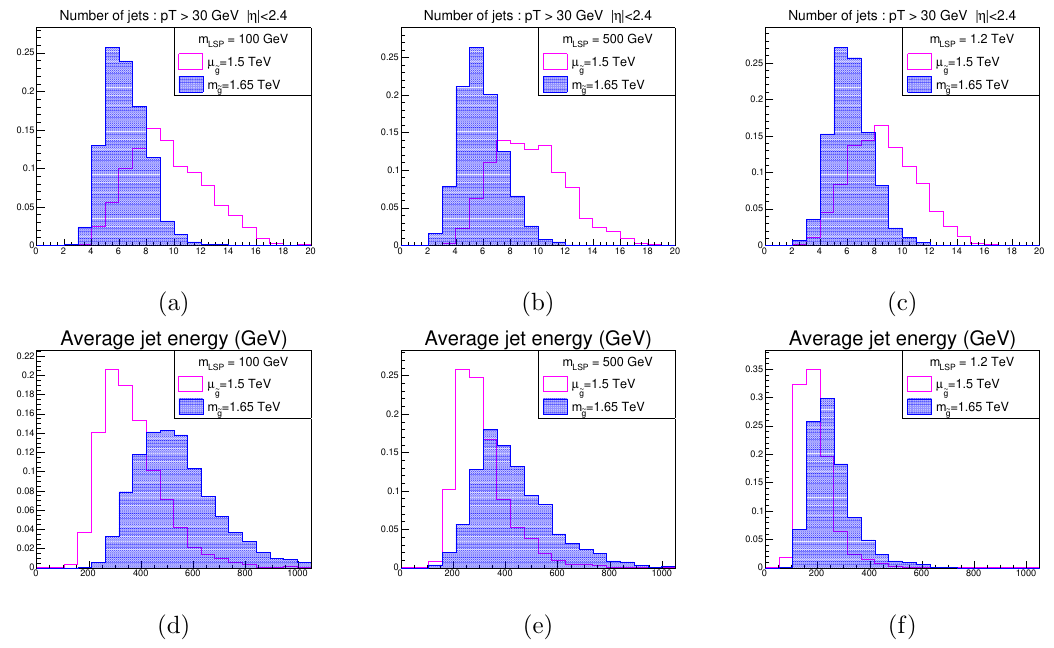
Figure 17. Comparison of MSSM gluino (blue) and gluino continuum (magenta) for di(cid:11)erent masses of LSP at the LHC with 13 TeV. Distributions are all normalized to 1. The chosen bench- marks are an MSSM gluino with a mass of 1.65 TeV and a gluino continuum with (cid:22) g = 1 : 5 TeV, which have equal production cross